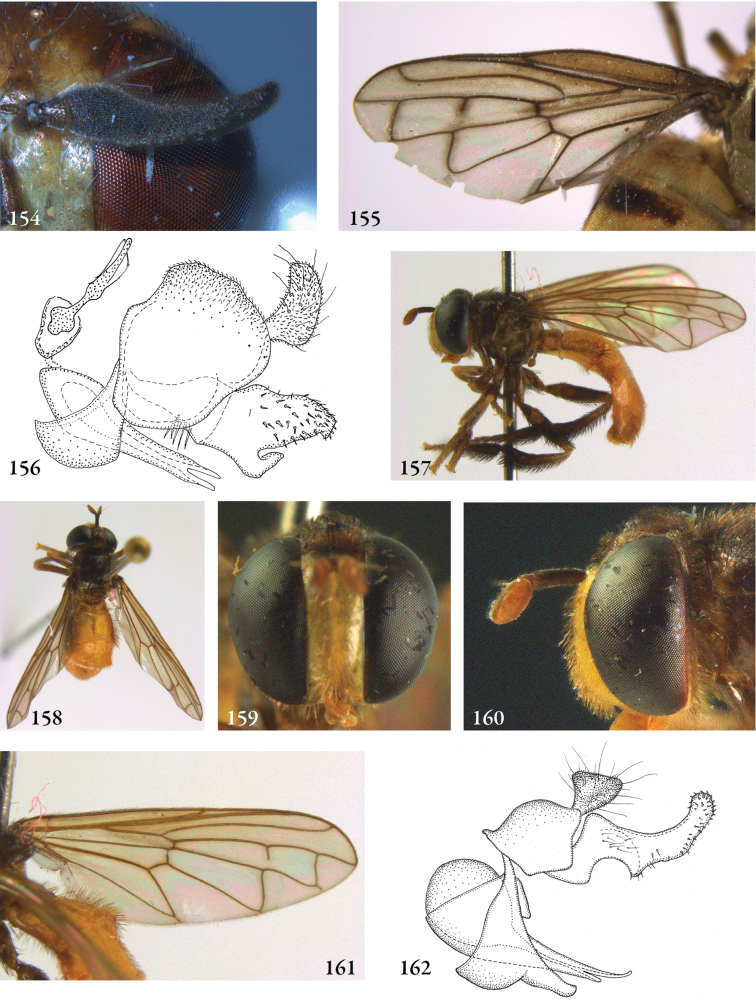
154–155
Menidon falcatus male (Costa Rica, coll. ZMAN): 154 antenna 155 wing 156
Menidon falcatus male (Costa Rica, coll M. Hauser), genitalia lateral 157–162
Mermerizon inbio male (holotype): 157 habitus lateral 158 habitus dorsal 159 head frontal 160 head lateral 161 wing 162 genitalia lateral.